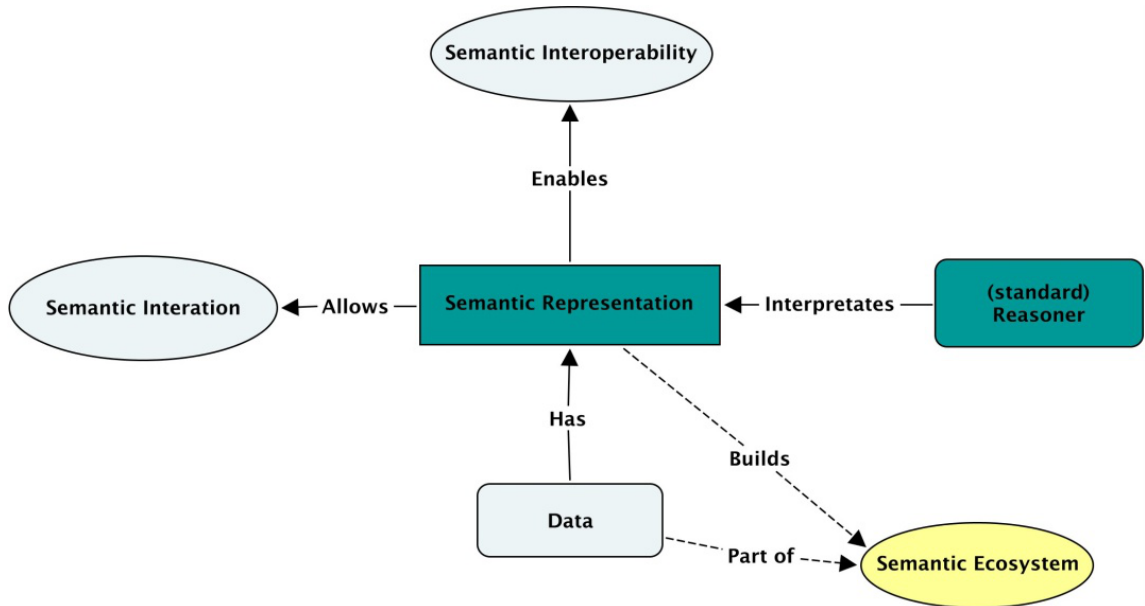
Figure 3. A light model for the Semantic Web by using concept